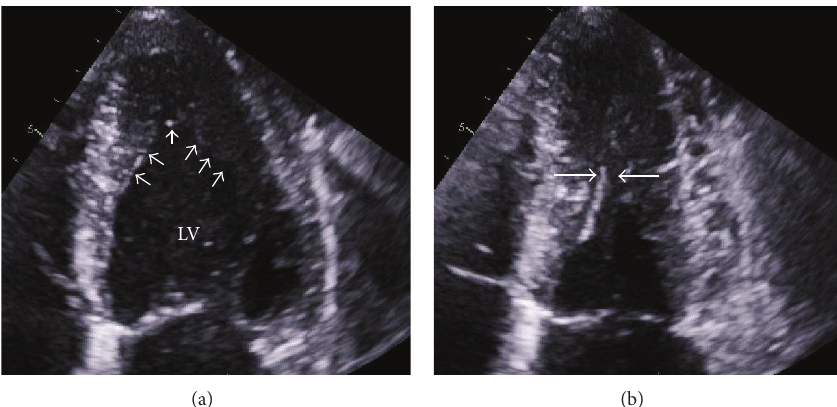
Figure 1: Apical hypertrophic cardiomyopathy. Transthoracic echocardiogram showing left ventricular (LV) apical hypertrophy in diastole ((a), arrows) and midcavity obliteration at end-systole ((b), arrows).